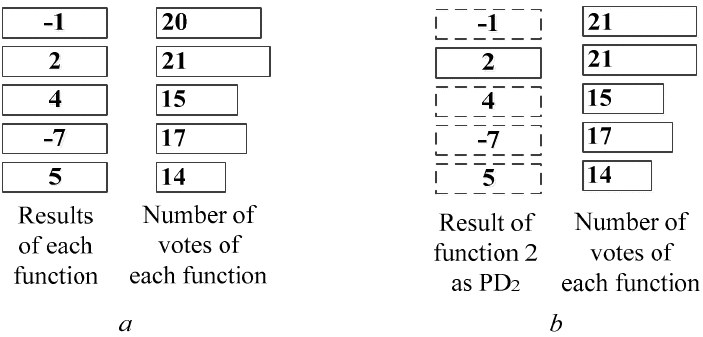
Figure 4. Sample data for one voting session: ( a ) result for each function, and ( b ) result for function 2.